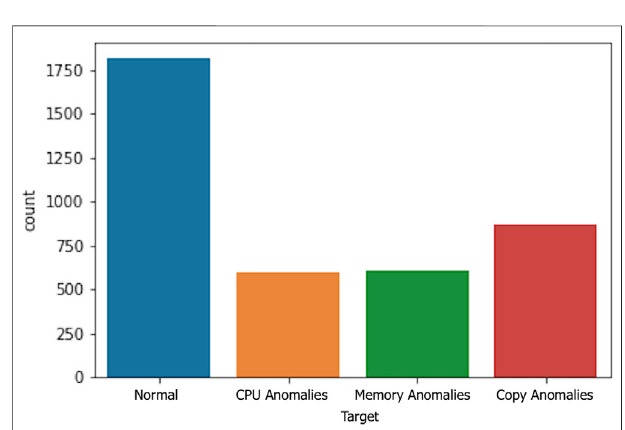
FIGURE 7 | Distribution of event/anomaly